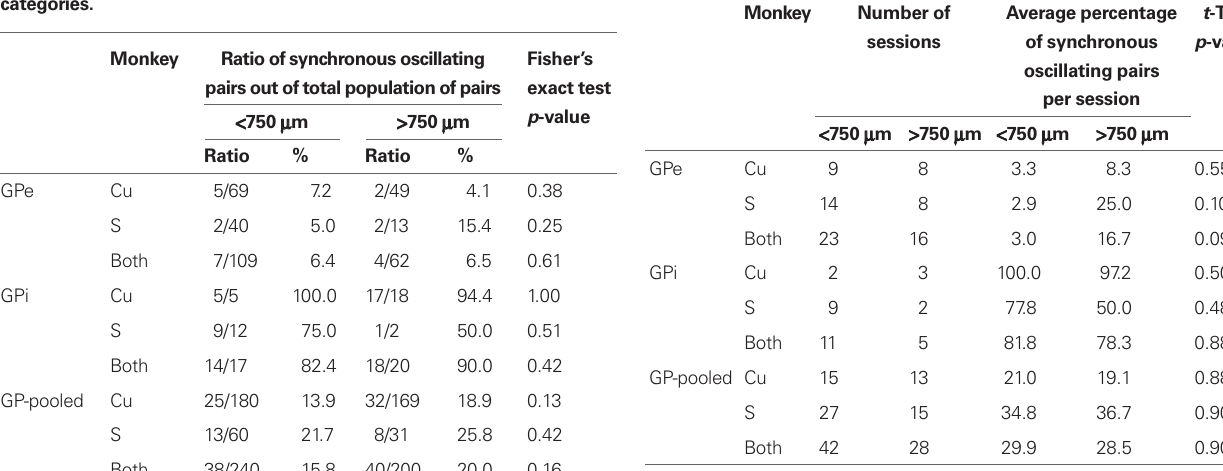
Table 4 | ratio of synchronous oscillating remote pairs in two distance categories.